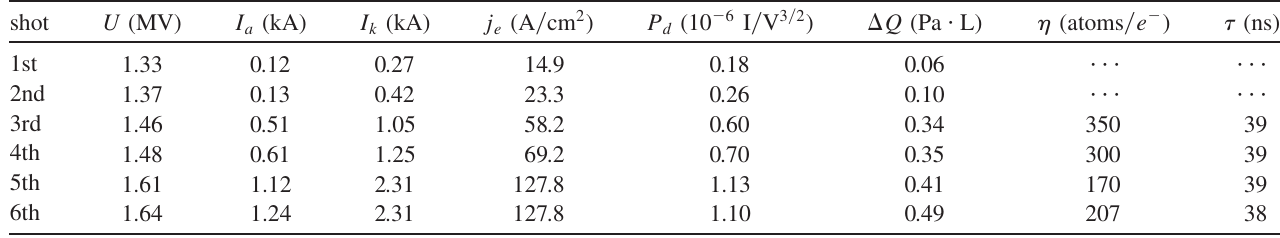
TABLE I. Results of six shot experiments of the CNT cathode: U is diode voltage, I a is anode current, I k is cathode current, j e is current density, P d is diode perveance, (cid:1) Q is the amount of outgassing, (cid:3) is ratio of outgassing and electron, and (cid:4) is CTT. The dots indicate that the data is not measured or calculated accurately.